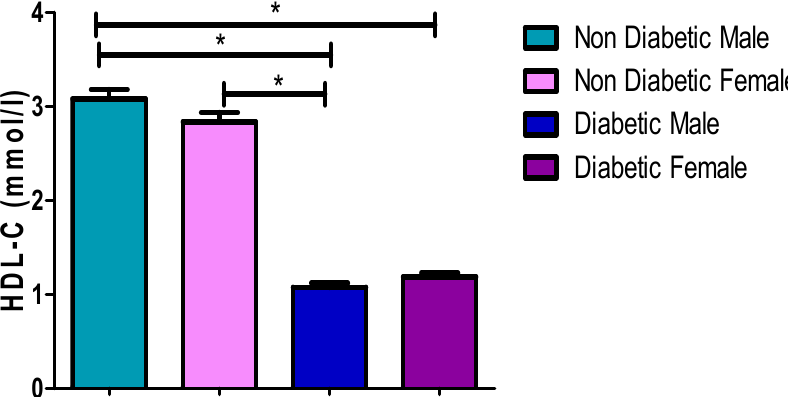
Figure 5. High-density lipoproteins cholesterol (HDL-C) concentrations. *, a significant statistical difference ( p -value < 0.05 ). The statistical bar ( ) shows the relationship between the four variables: there was a significant statistical difference in the HDL-C concentrations between the non-diabetic male and diabetic female, the non-diabetic male and diabetic male, and between the non-diabetic female and diabetic male, respectively.